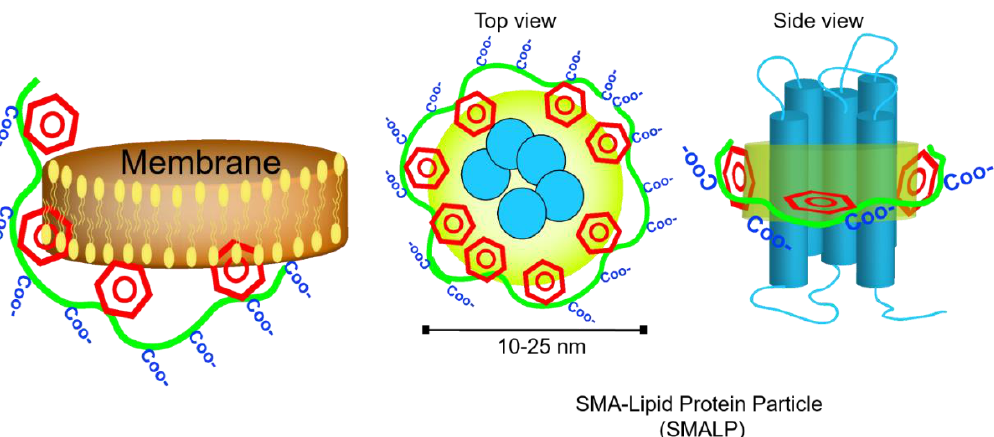
Figure 5. Adsorption, and hydrophobic interaction of styrene moieties (or their hydrophophobic counterparts in other membrane solubilizing polymers such as DIBMA) with acyl chains of phospholipids in lipid bilayer leads to fragmentation the membrane and formation of nanoscale entities called polymer-lipid particles (i.e., SMALP, DIBMALP, etc.).